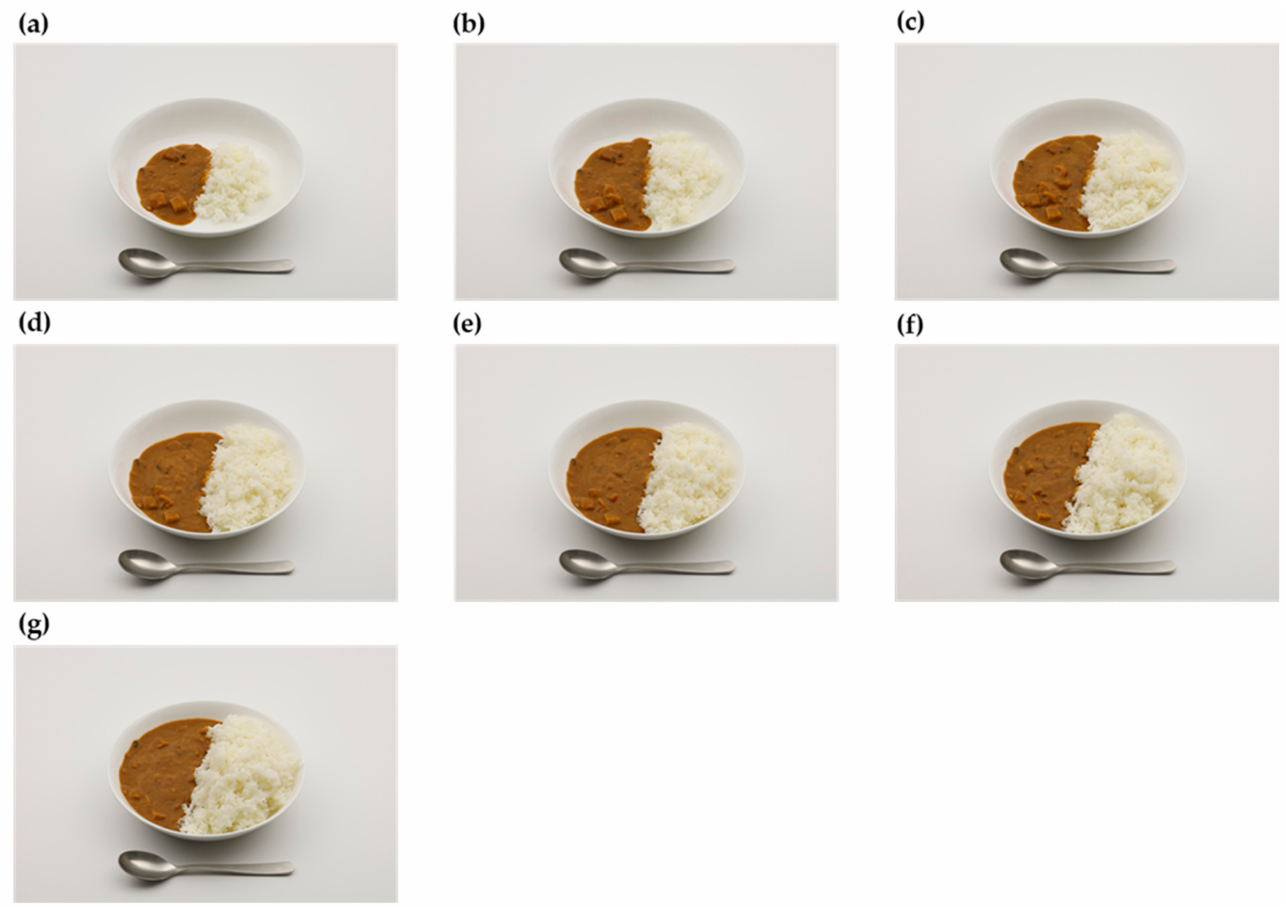
Figure 2. Example of a series of photographs for curry and rice. The portion size gradually increases from photo ( a – g